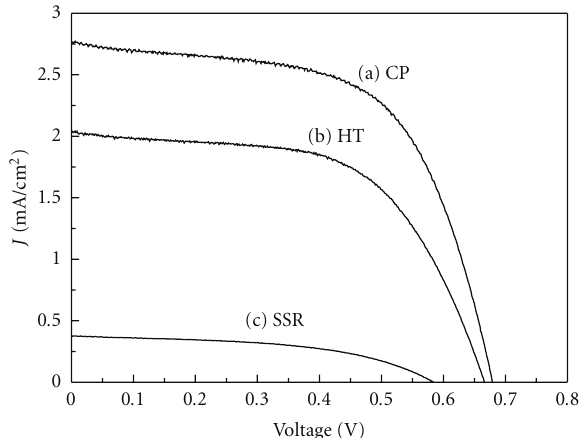
Figure 3: J -V curves of the cells prepared by di ff erent particles: (a) CP, (b) HT, and (c)